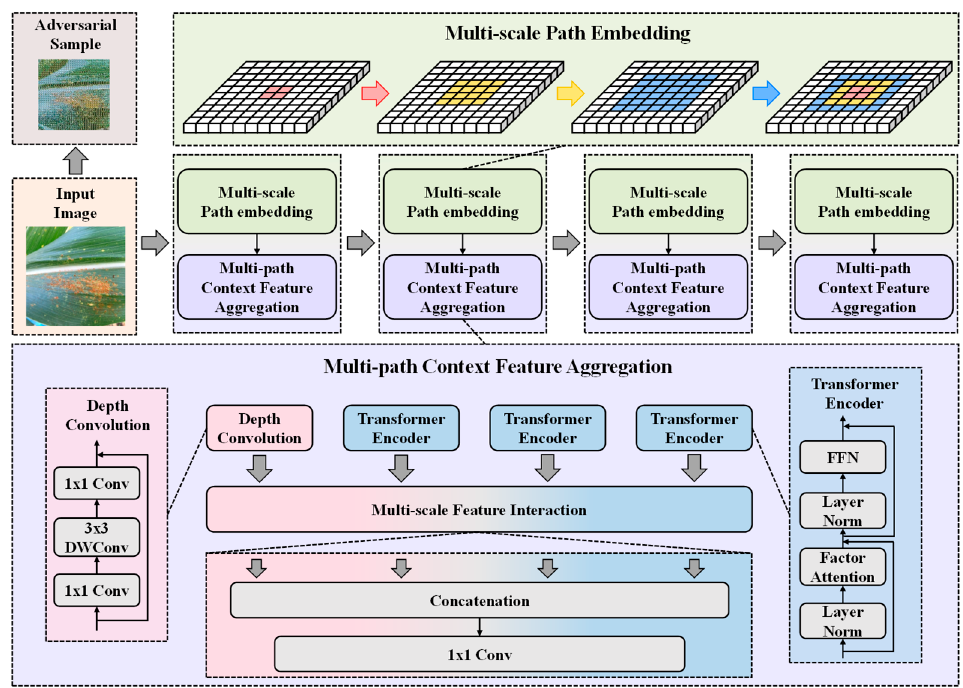
Figure 2. Overview of the proposed adversarial training, collaborating, multi-path context-feature aggregation network.